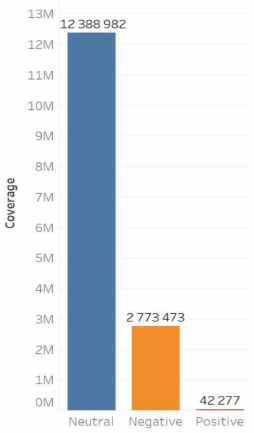
Figure 4. Sentiment of the Moscow actors’ content. The sentiment features of digital footprints also indicate a greater intensity of negative emotions in the Moscow group: 29.03% of negative comments; and in the regional group only 4.39% of comments are negative (Figures 5 and 6).